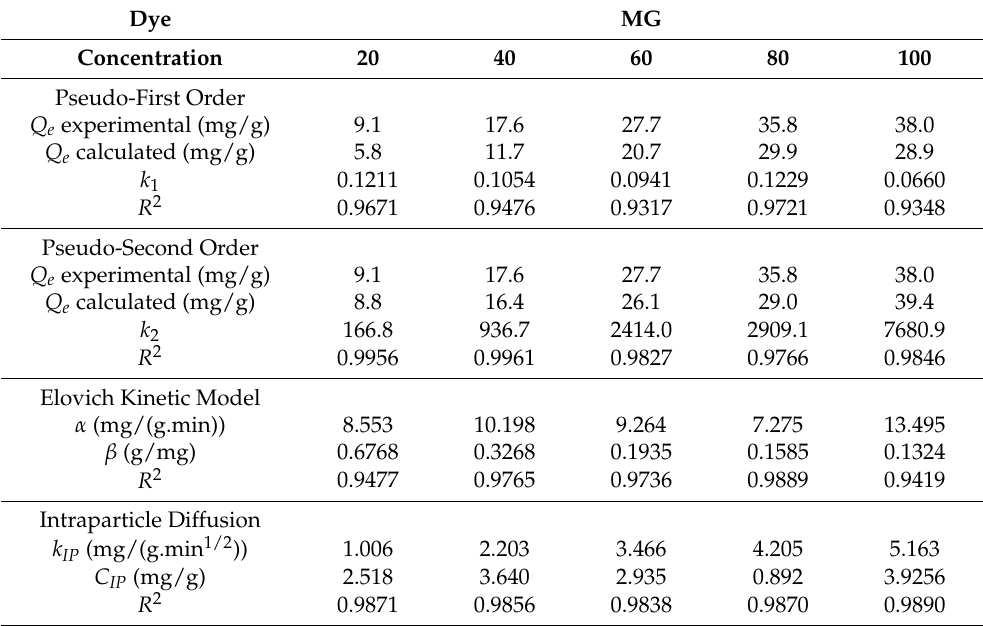
Table 2. Parameters for pseudo-first order, pseudo-second order, Elovich kinetic model, and intra- particle diffusion for